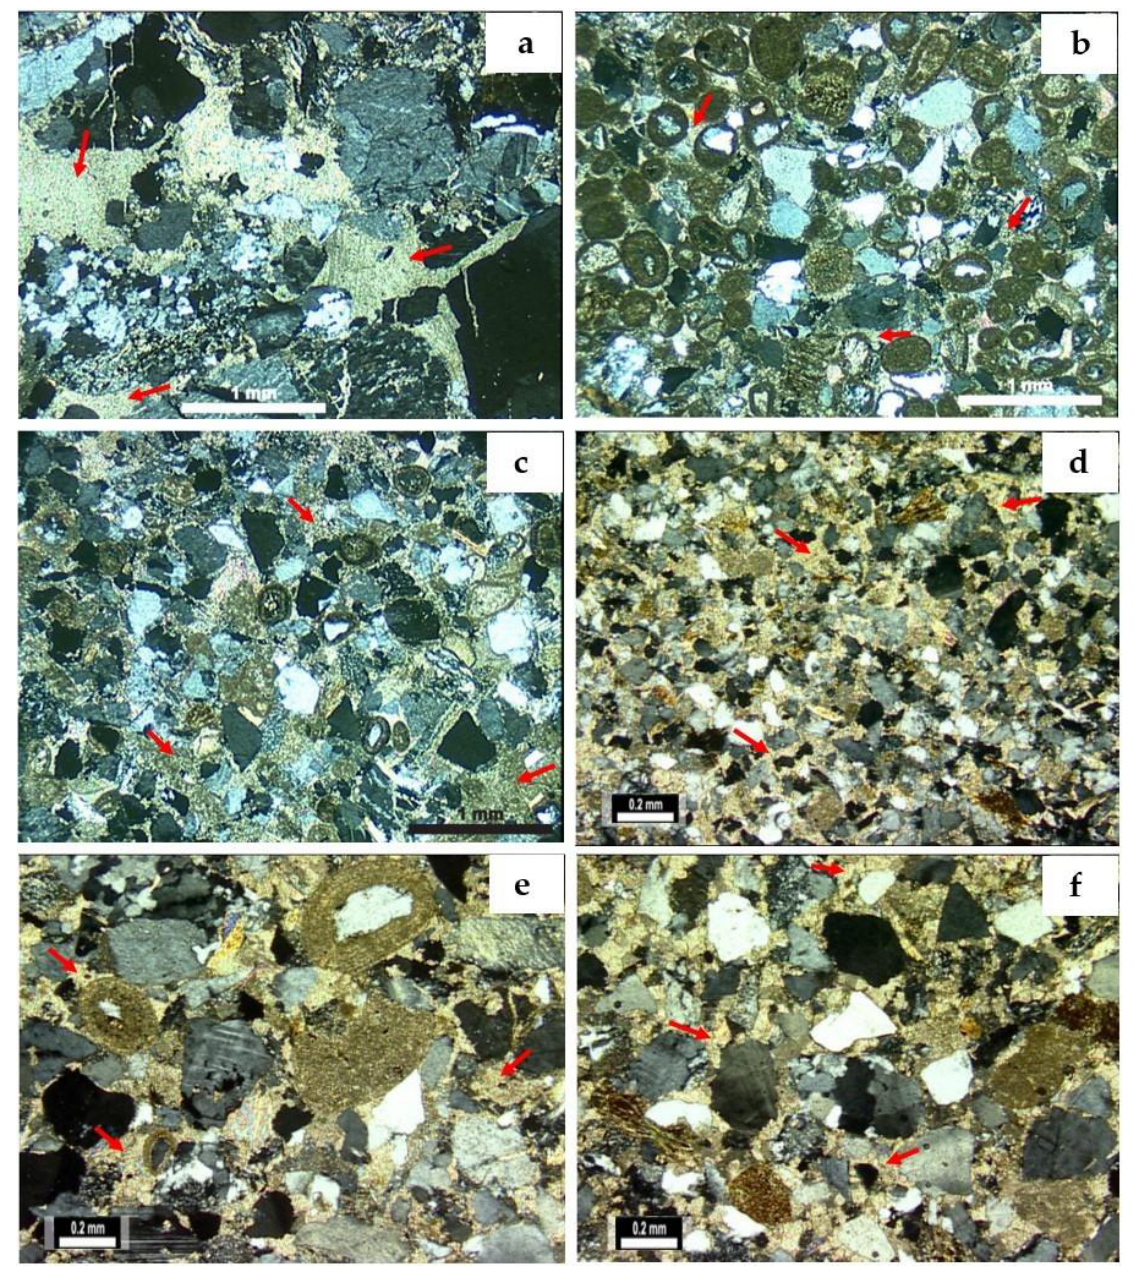
Figure 17. Photomicrographs with crossed polarizers of core samples of the turbidite sandstone reservoirs (Cabrito Member) of Benfeito-1 exploratory well: ( a ) 895 m to 900 m depth—very coarse sandstone with fractured grains. Poikilotopic calcite (indicated by red arrows) filling intergranular and grain fracture pores. Intense grain replacement. ( b ) At 950 m to 955 m depth—hybrid medium sandstone rich in ooids intensely cemented by calcite (indicated by red arrows). ( c ) At 980 to 985 m depth—hybrid medium sandstone with subangular grains heavily cemented by calcite (indicated by red arrows). Note the partial replacement of grains by calcite. (Photomicrographs with crossed polarizers of core samples of the turbidite sandstone reservoirs (Cabrito Member) of Freixial-1 exploratory well: ( d ) fine sandstone, poorly sorted, cemented by mosaic calcite (indicated by red arrows) and poikilotopic. ( e ) Poorly sorted hybrid feldspathic sandstone, rich in ooids, intensely cemented by mosaic calcite (indicated by red arrows) and poikilotopic. ( f ) Poorly sorted sandstone with subangular grains, cemented by calcite in mosaics (indicated by red arrows), adapted from Garcia et al.